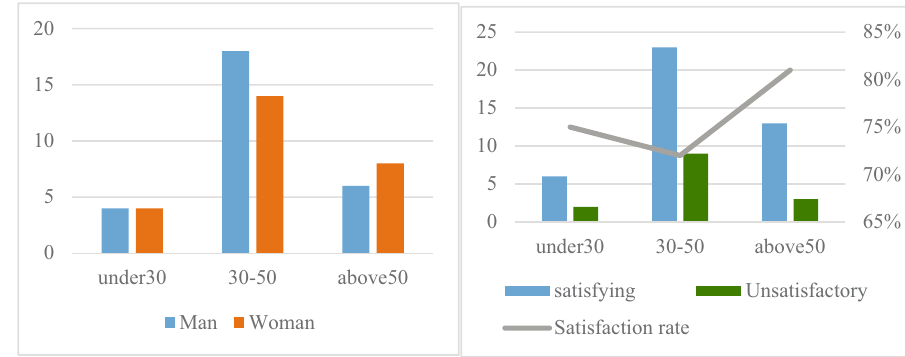
Figure 3: Graph of survey results.